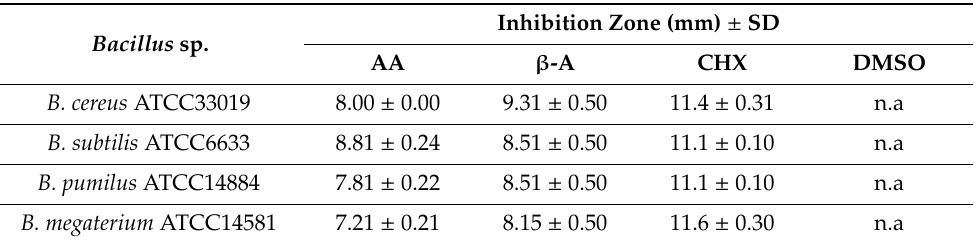
Table 1. Disc di ff usion of isolated compounds against Bacillus